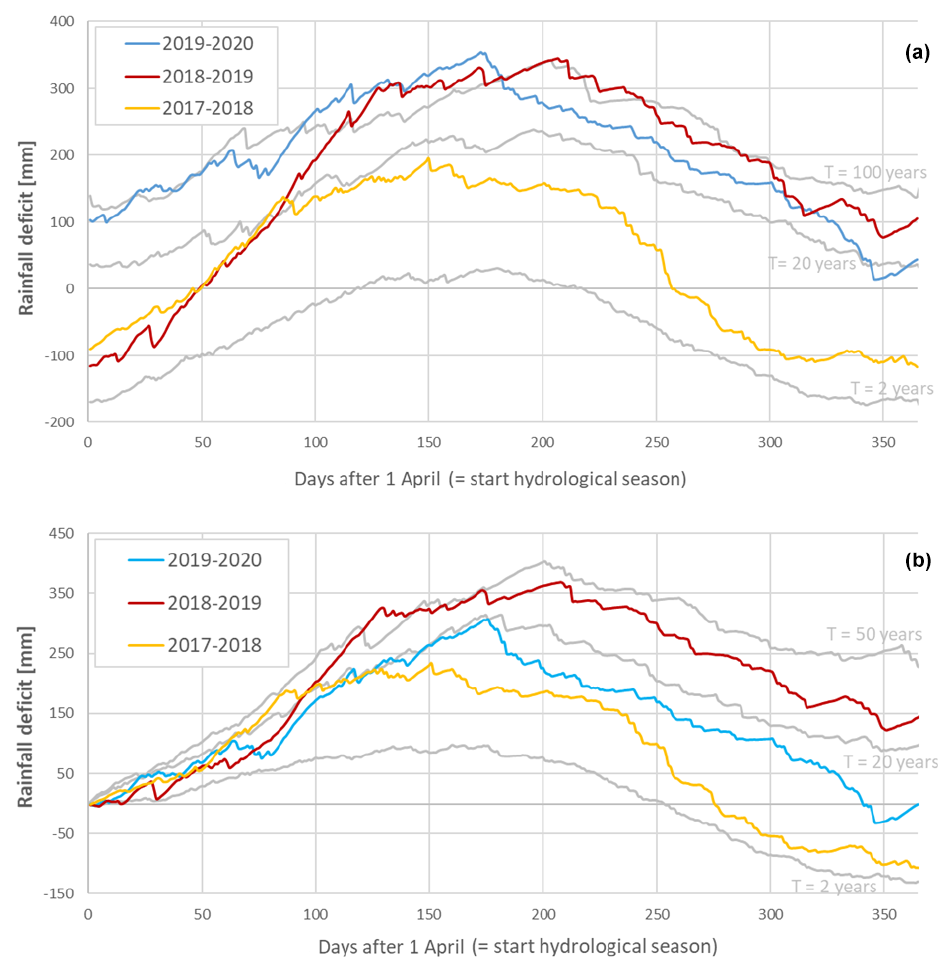
Figure 3. The rainfall deficit for the meteorological station of the Royal Meteorological Institute (KMI) in Ukkel, Belgium. The solid colored lines represent the rainfall deficit for the hydrological years in the period 2017–2020, while the solid grey lines represent the long- term reference statistics (computed for the 100-year period 1901–2000) with T as the return period, which represents the mean time between two successive exceedances of a given deficit value and is computed in an empirical way (Willems, 2000, 2013). Panel (a) uses a continuous computation, while panel (b) starts from a zero deficit on the first of April (the start of the hydrological year). The colors represent the rainfall deficit in 2017 (light blue), 2018 (red) and 2019